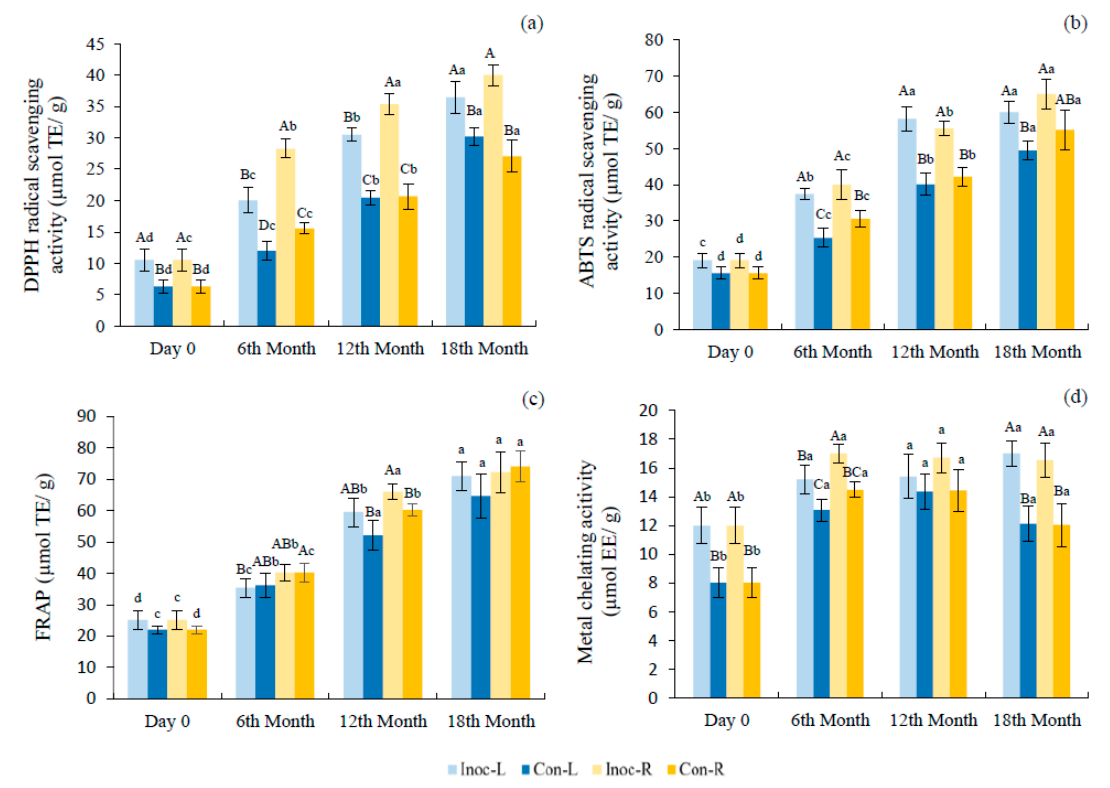
Figure 3. DPPH radical scavenging activity ( a ), ABTS radical scavenging activity ( b ), ferric reducing antioxidant power (FRAP) ( c ), and metal chelating activity ( d ) of water extracts from shrimp paste with/without B. subtilis K-C3 inoculation during storage for 18 months at low (4 °C) and room (28 °C) temperature. Different lowercase letters indicate significant differences (p < 0.05) as affected by storage time. Different uppercase letters indicate significant differences (p < 0.05) between samples at the same storage time.